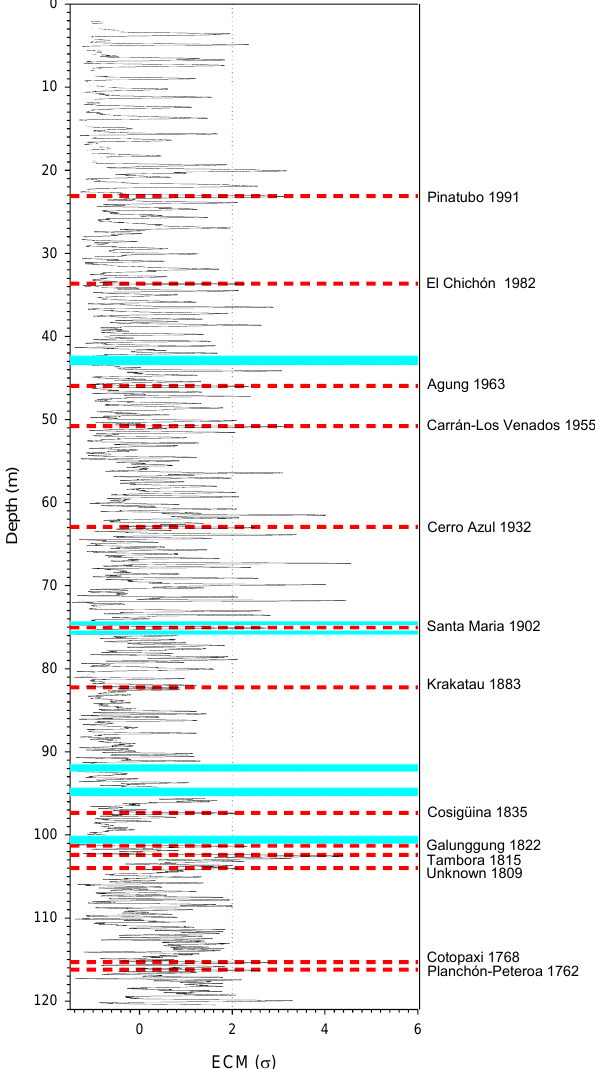
Figure 5. Continuous record of ECM (except for six measurement gaps shown as cyan bands). Normalized conductivity (black line) is expressed as a multiple of standard deviation ( σ) . The 2 σ threshold is shown as a dotted vertical line, and identified volcanic peaks are shown as dashed red horizontal